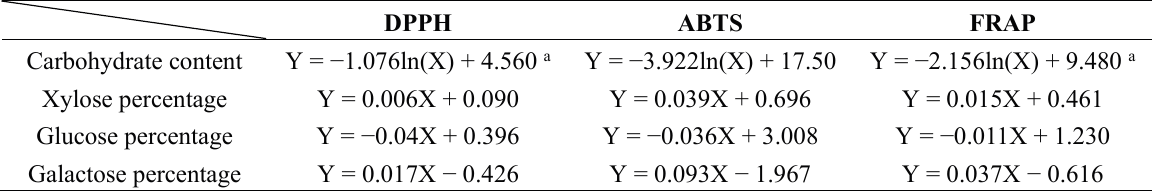
Table 5. Pearson correlation coefficients between carbohydrate content/monosaccharide percentage and antioxidant activities (IC 50 ). DPPH ABTS FRAP DPPH 1.000 ABTS 0.580 * 1.000 0.799 ** FRAP 0.931 ** 0.799 ** 1.000 Carbohydrate content − 0.671 * a − 0.915 ** − 0.667 * a Xylose percentage 0.682 * 0.796 ** 0.797 ** Glucose percentage − 0.616 * − 0.993 ** − 0.803 ** Galactose percentage 0.830 ** 0.844 ** 0.883 **